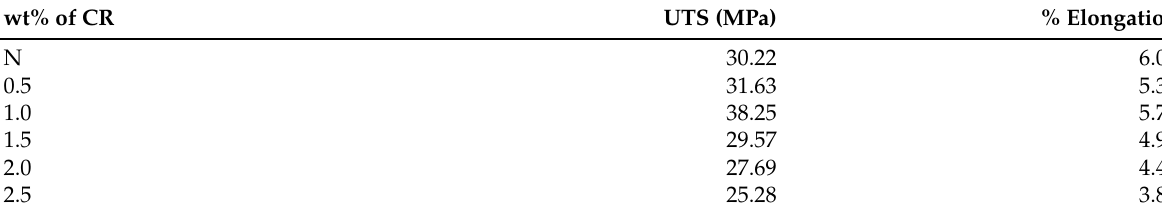
Table 9: Tensile properties for various composition of CFR